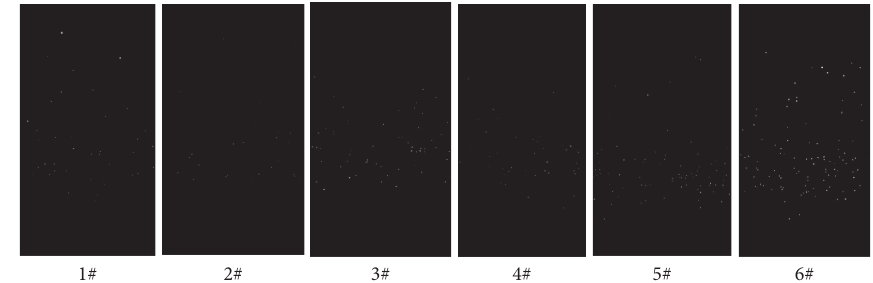
Figure 5: Picture of pit treatment on witness plate after test.